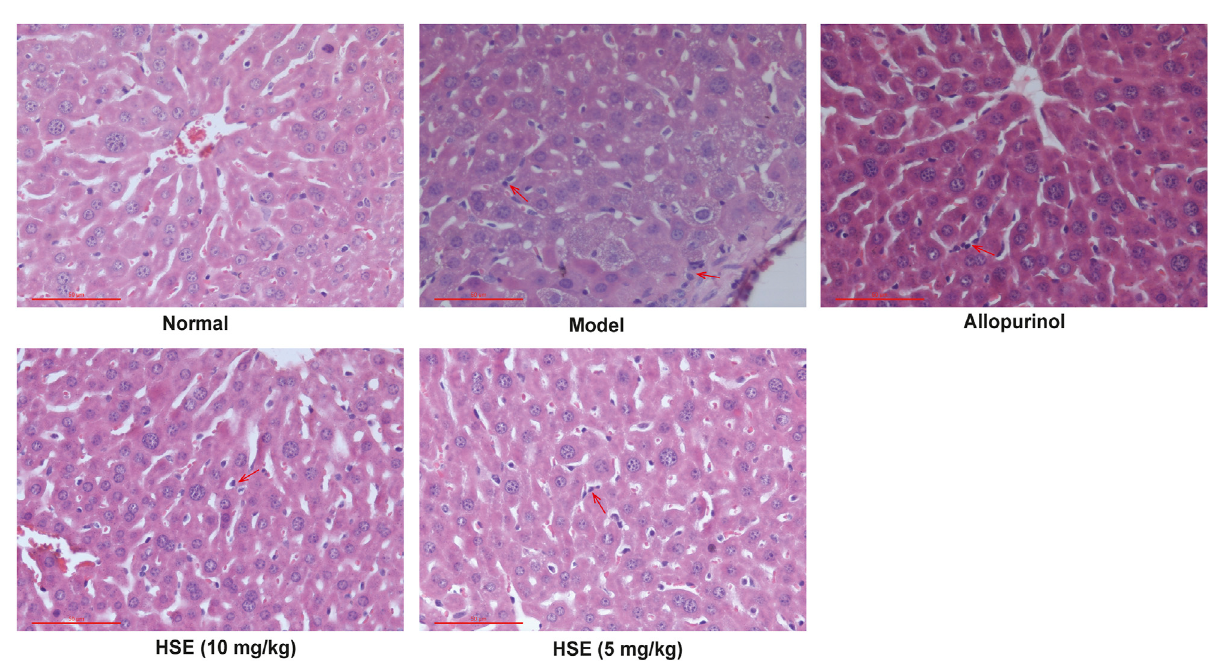
Hepatoprotective effects of hesperetin (HSE) on liver morphology in mice with hyperuricemia induced by yeast extract. Liver sections subjected to hematoxylin and eosin staining (n = 10) are presented at a magni fi cation of ×400. Scale bar, 50 μ m. Hesperetin (HSE) (5 and 10 mg/kg) and allopurinol (10 mg/kg) were administered, respectively, to mice in addition to yeast extract treatment. HSE, hesperetin. In fl ammatory cell in fi ltration was point out with red